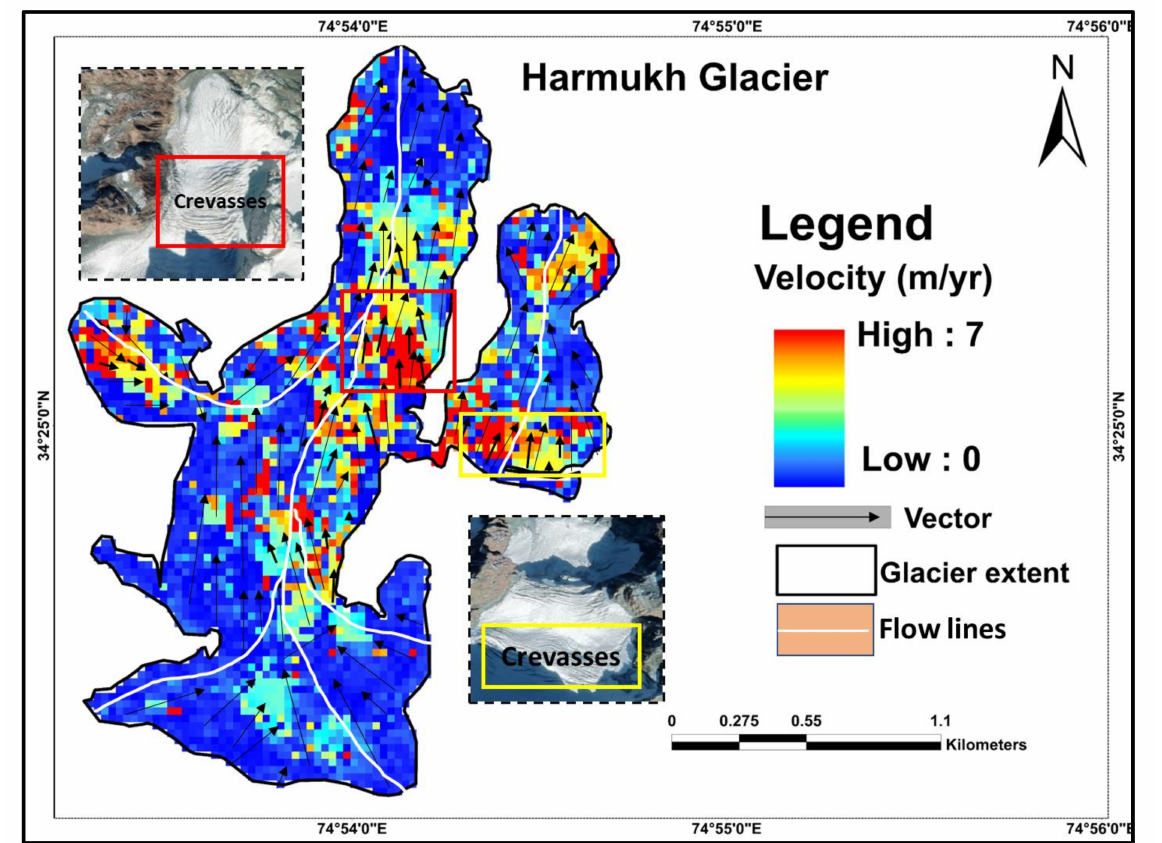
Figure 10. Glacier surface velocity/displacement with vectors showing flow direction. The red and yellow squares depict the maximum velocity near the